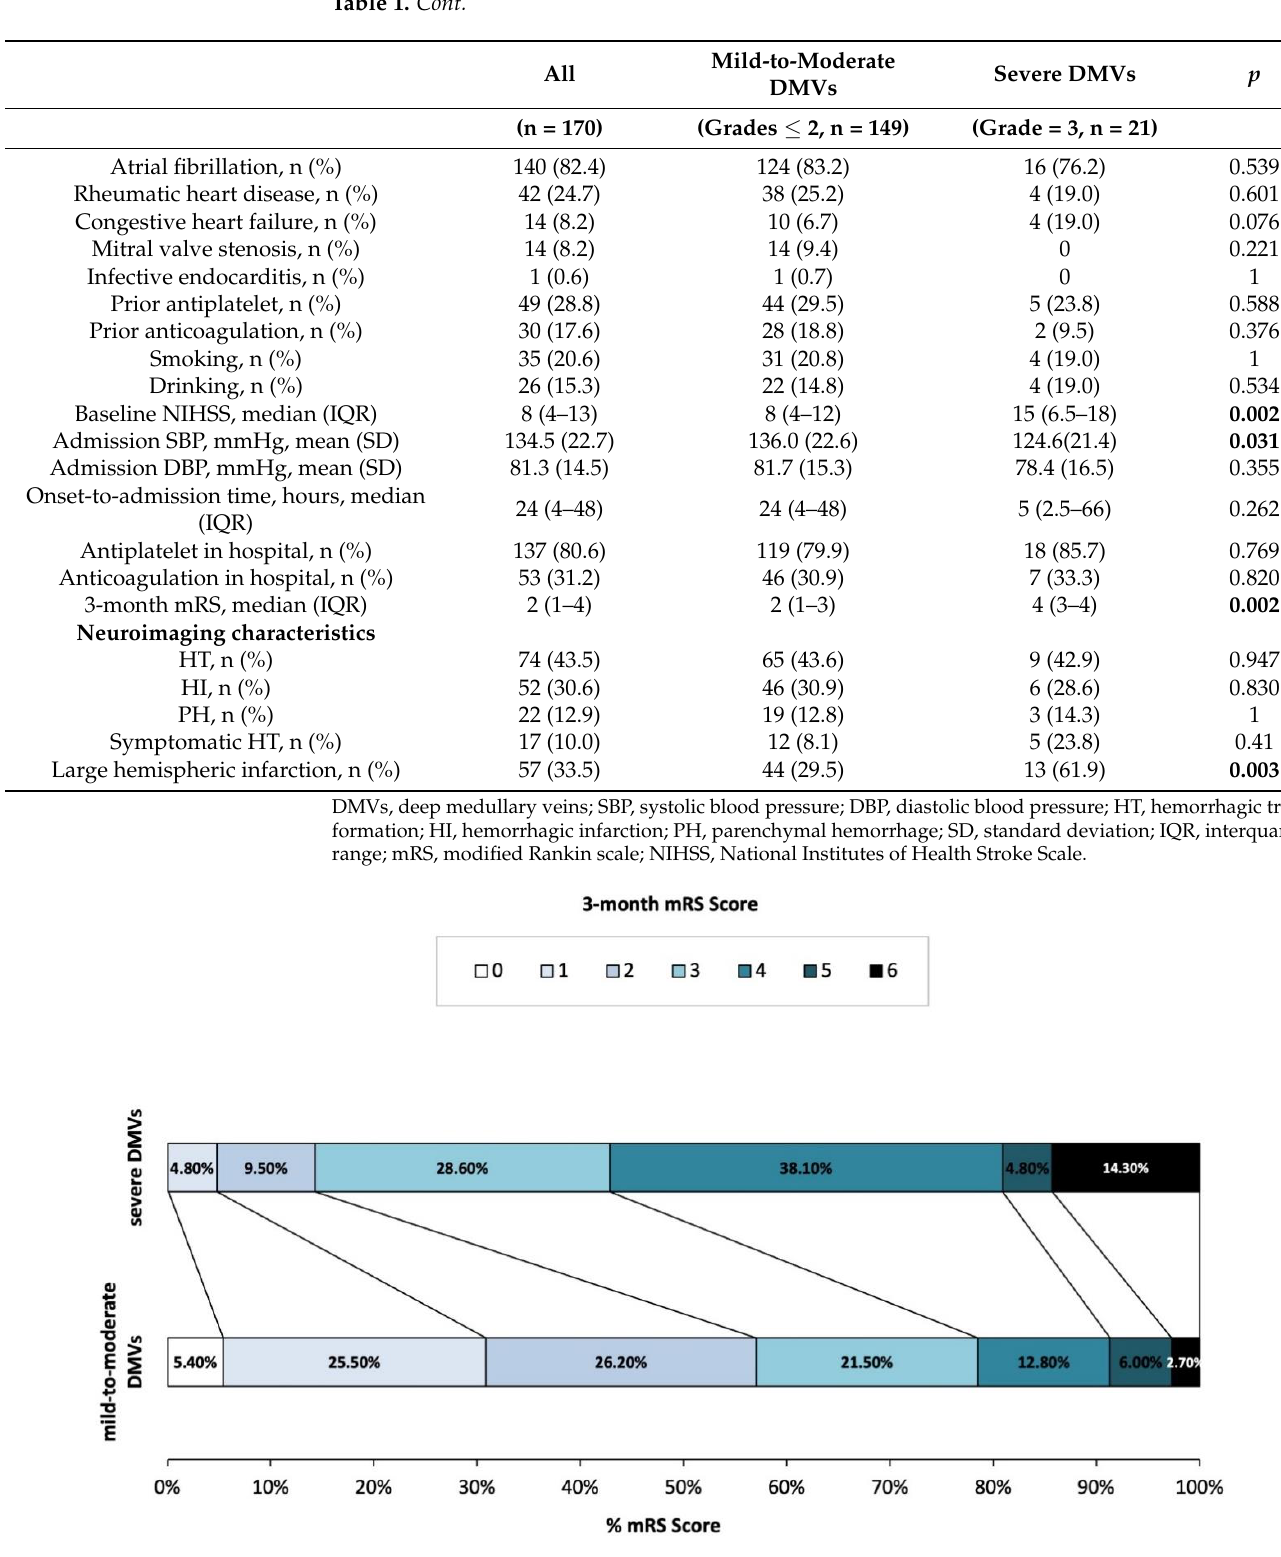
Figure 3. Distribution of modified Rankin scale at 3-month in patients with different DMV